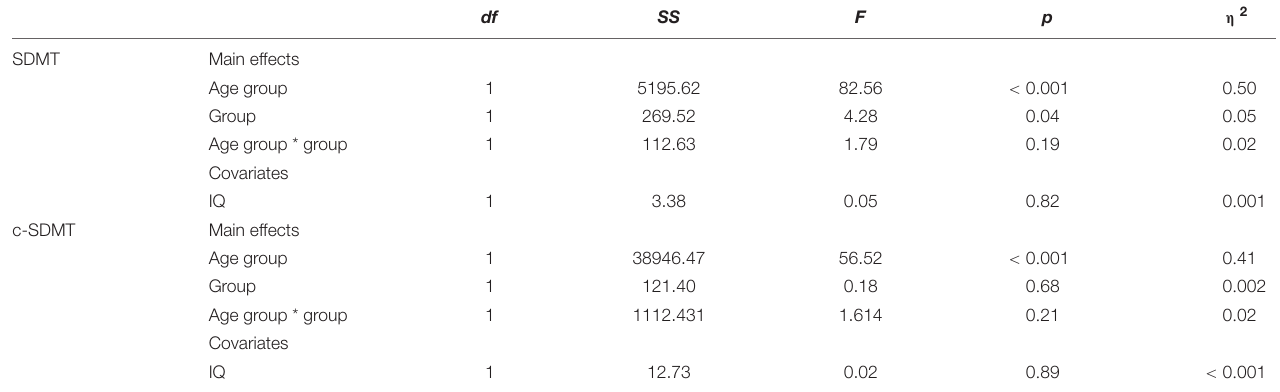
TABLE 2 | MANCOVA results.